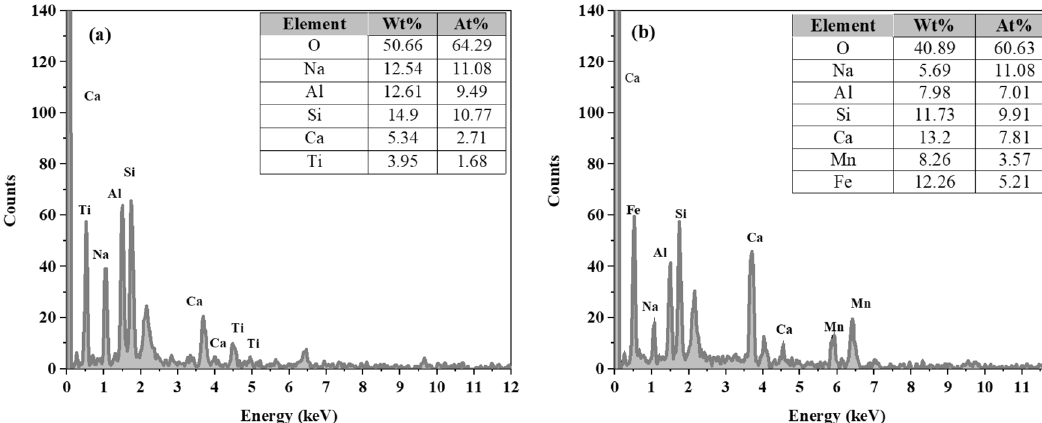
Figure 4. EDS analysis of ( a ) RM and ( b ) MRM.